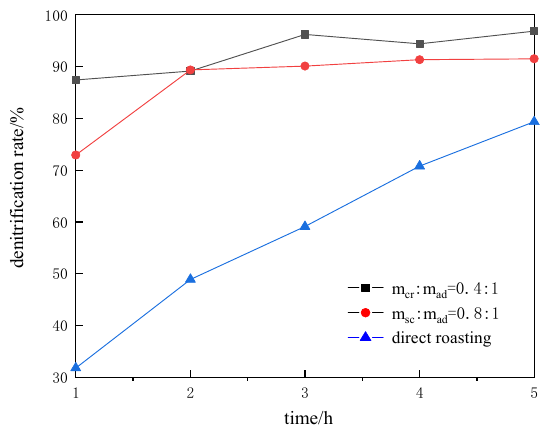
Figure 8. Effect of different times on the nitrogen removal rate of high-nitrogen aluminum dross. It can be seen from Figure 8 that as the roasting time increased, the denitrification degree of the high-nitrogen aluminum dross showed an upward trend. For samples with cryolite added, the denitrification degree increased significantly after 2 h of